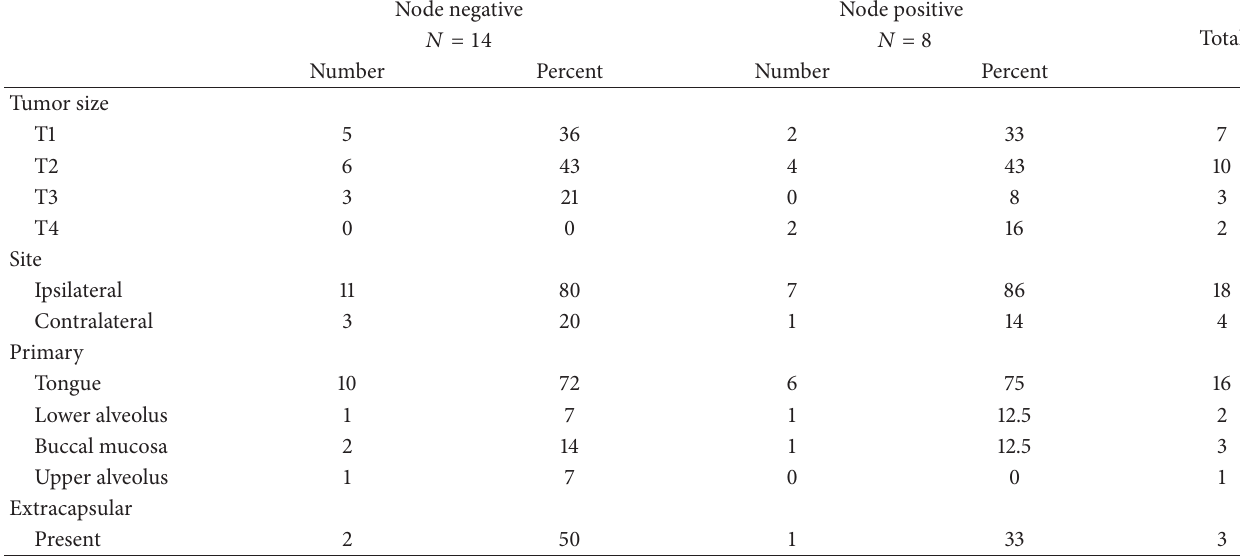
Table 5: Regional failures in clinically node negative and node positive neck.